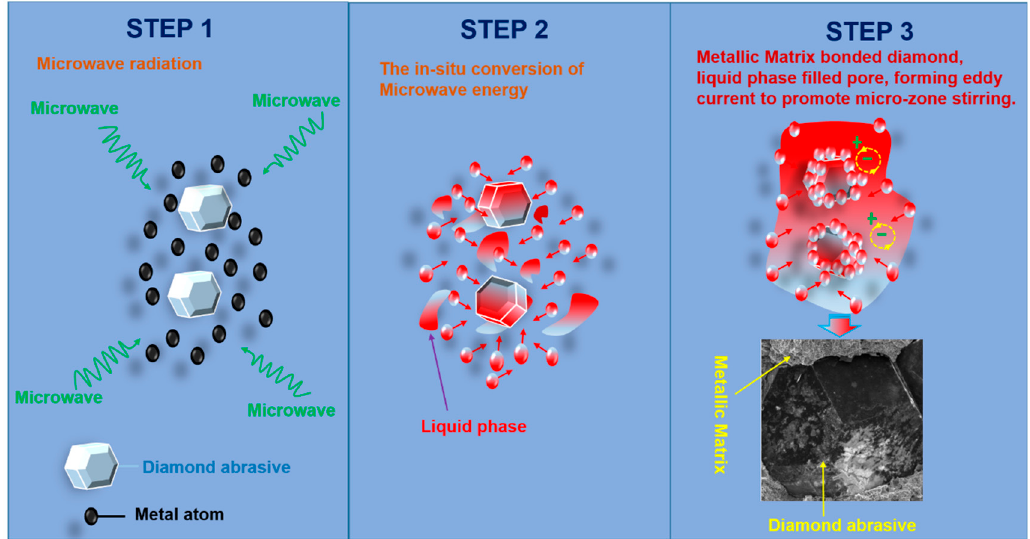
Figure 11. The schematic diagram of a possible mechanism for the MPS.